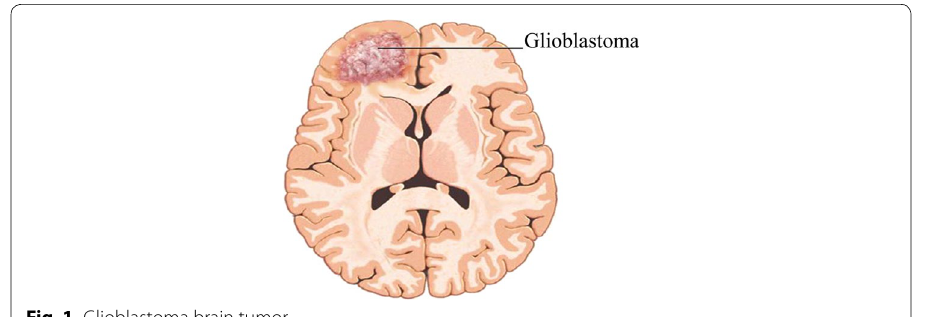
Fig. 1 Glioblastoma brain